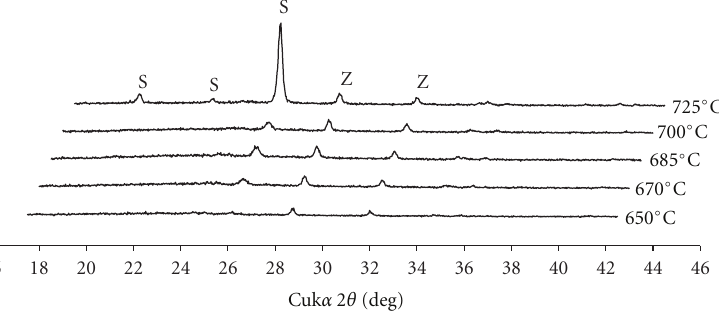
Figure 6: XRD patterns recorded of the samples after heat treatment for 10 min in the specified temperatures: S: β -LiAl[Si 2 O 6 ]-ss; ZS: ZrSiO 4 ; Z: ZrO 2 .